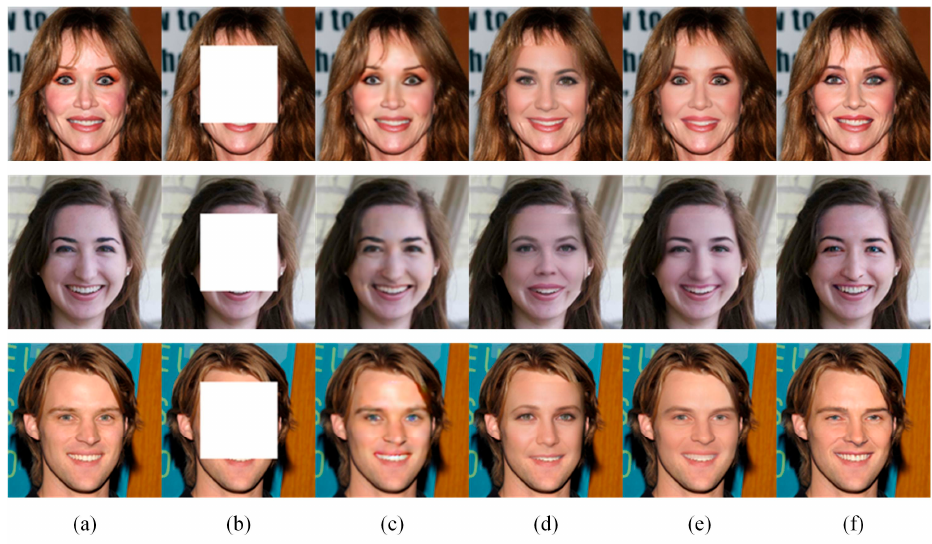
Figure 6. Results on randomly masked square: ( a ) Ground truth; ( b ) Input image; ( c ) Partial; ( d ) Pennet; ( e ) GapNet; ( f ) Ours.